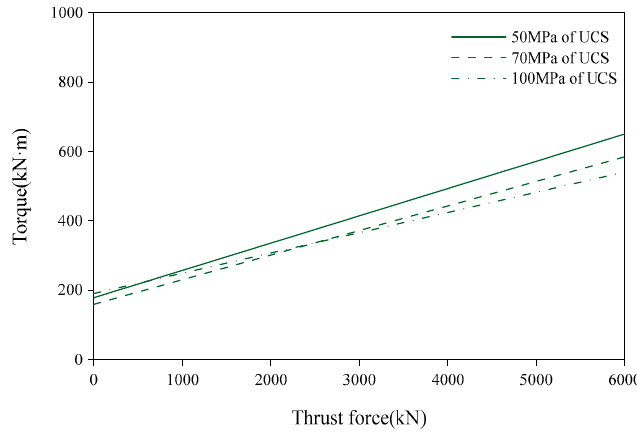
Figure 9. Regression lines of the relationships between thrust force and torque according to the UCS (Uniaxial compressive strength) of rock mass.